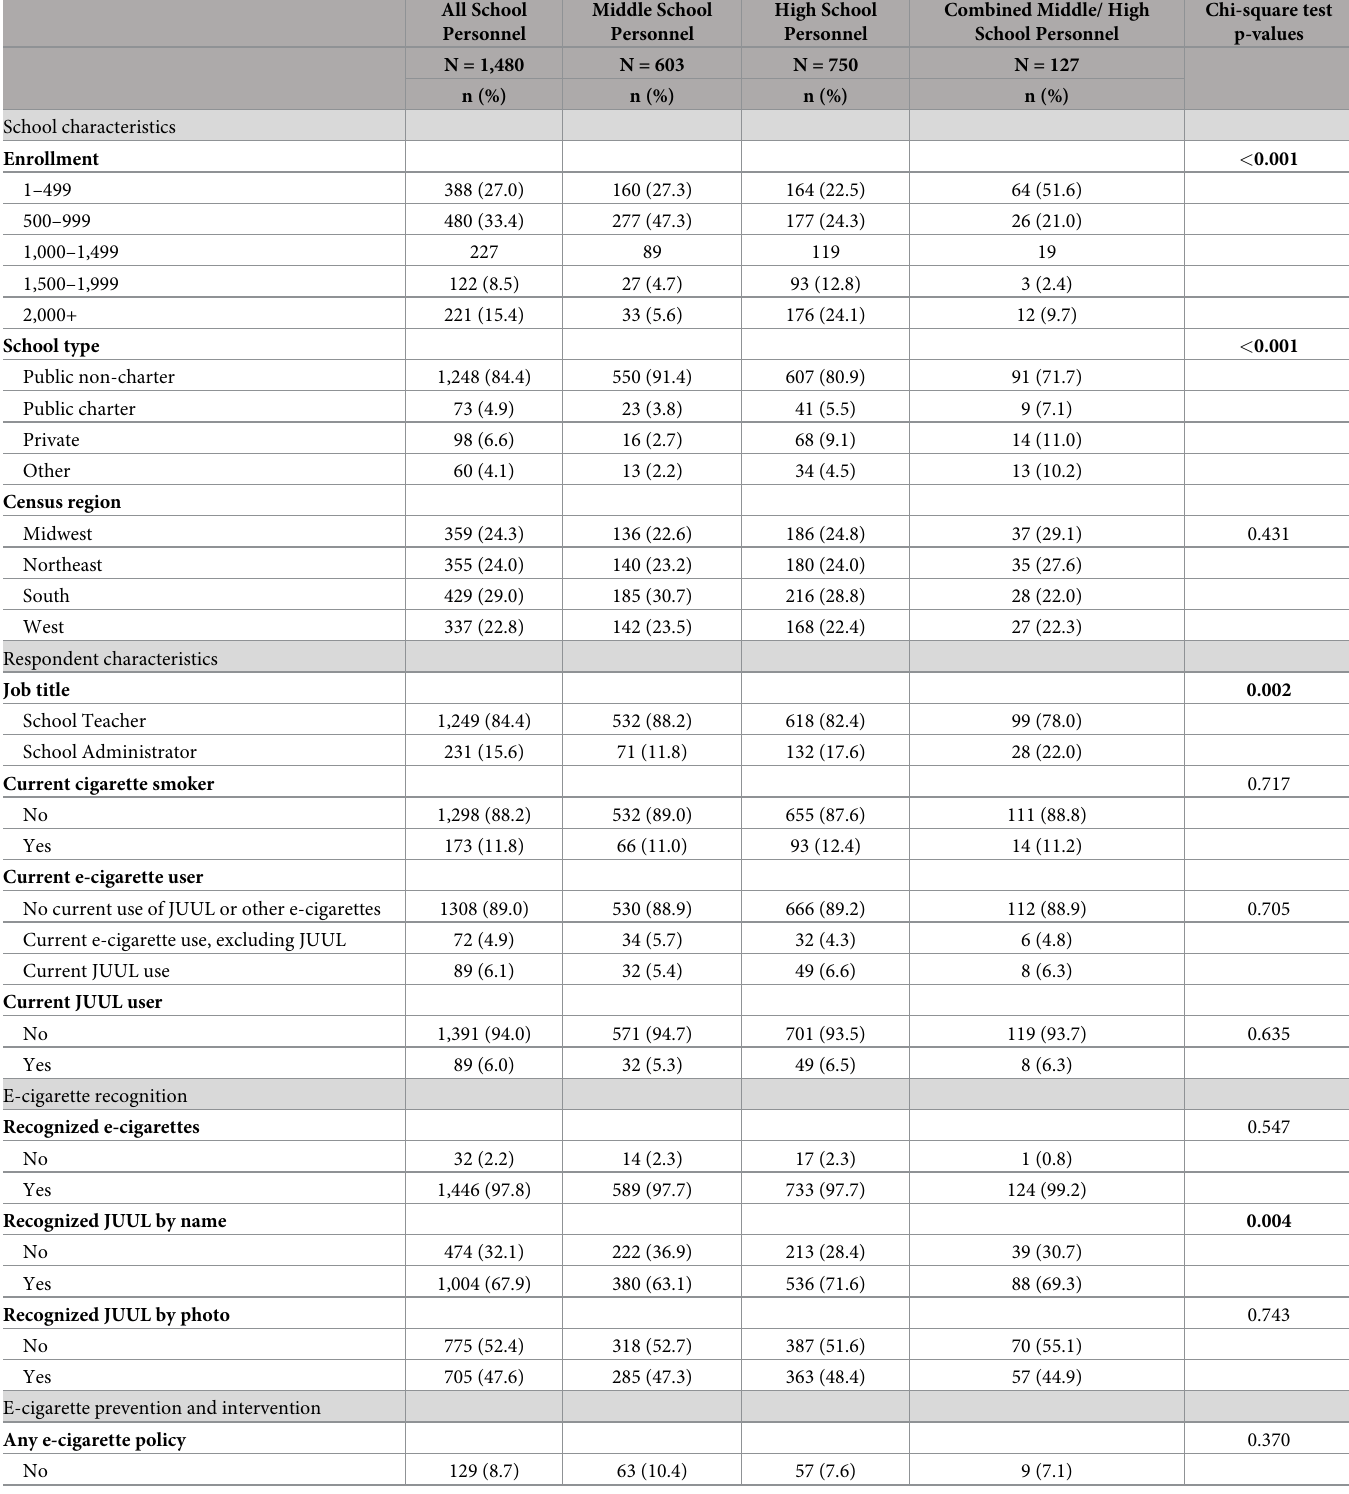
Table 1. Characteristics of schools and school personnel by school